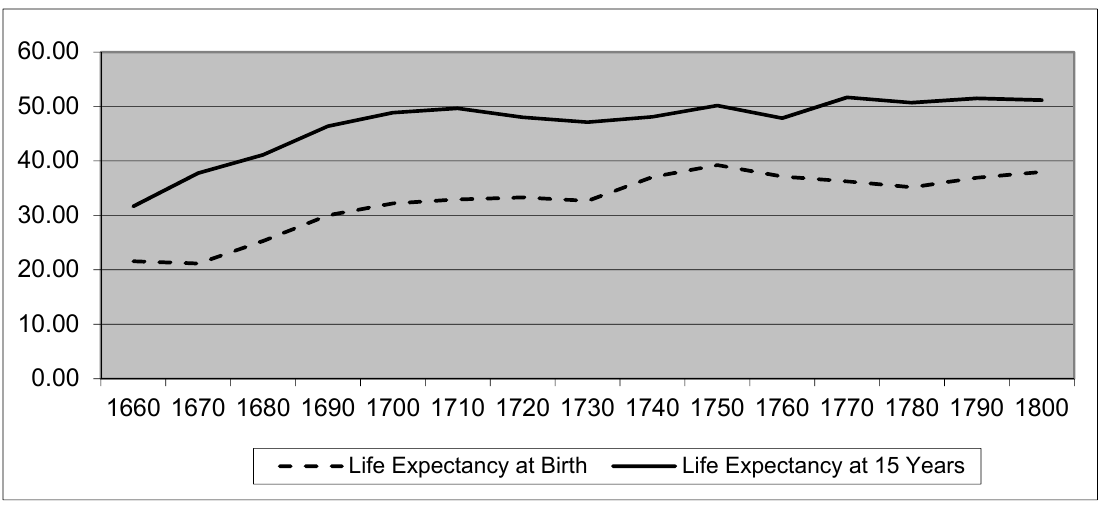
Figure 5. Life expectancy calculated from the L&MQM burial registers.